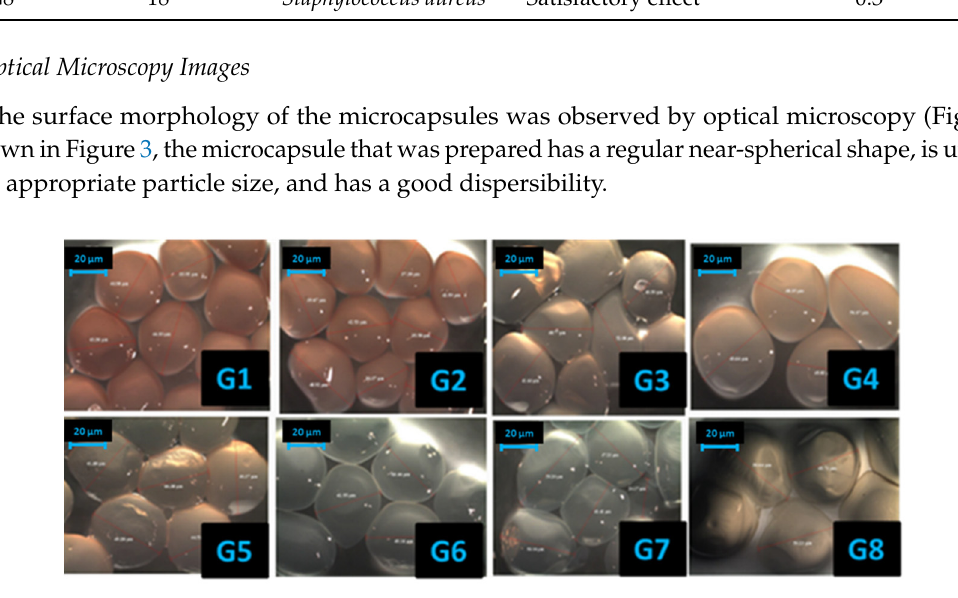
Table 3. Evaluation of the antimicrobial activity of the microcapsules.